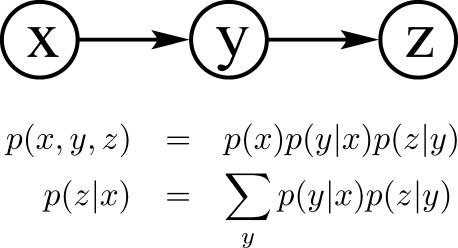
Serial Connection